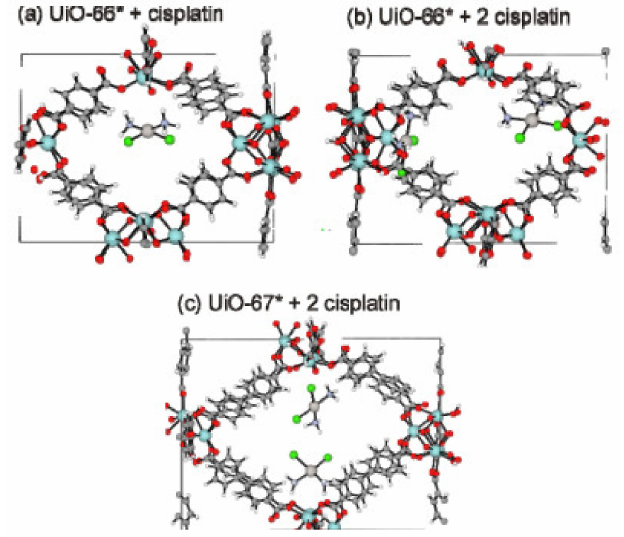
Figure 7. Snapshots of cisplatin stored in UiO-66 and UiO-67 coated with modified poly( ε -caprolactone) based on MD simulations provided by Fillipousi et al. (Ref.